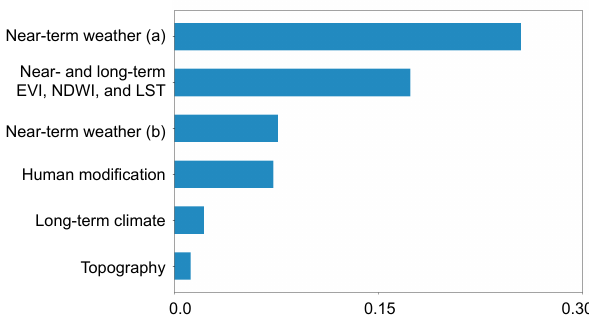
Figure 3. Graph of relative variable importance, based on the per- mutation importance measure, which directly measures importance by observing the effect on model accuracy by randomly permut- ing the values of each predictor variable. Because random for- est “spreads” variable importance across collinear variables, non- independent variables were grouped together to determine their col- lective importance (see Table 1 for details on the variable groups). Near-term weather variables (a) include the energy release compo- nent, burning index, 100 and 1000h fuel moisture, relative humid- ity, and precipitation. Near-term weather variables (b) include tem- perature, vapor pressure deficit, specific humidity, solar radiation, wind speed, and wind